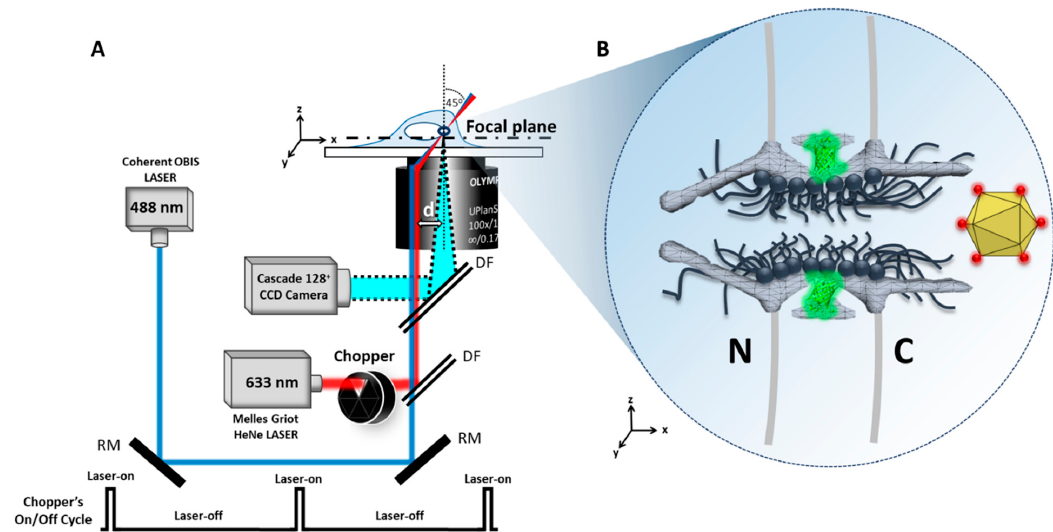
Figure 4. Optical schematic of the SPEED microscope setup. ( A ) Co-alignment of 488 and 633 nm laser beams that were shifted by ~237 µ m d from the optical axis of the objective to generate an inclined illumination volume at an angle of 45° to the perpendicular direction by using a micrometer stage. The 633 nm laser was chopped by an optical chopper to achieve an on–off laser mode ratio of 1:10 (on–off). The longer laser-off time gives particles transiting the NPC sufficient time to escape from the illumination volume and for fresh fluorescent cargo to diffuse from the cytoplasm or the nucleus into the NPC. ( B ) A single Alexa Fluor 647-labeled AAV2 particle approaching a single GFP-labeled NPC from the cytoplasm C to transport to the nucleus N .